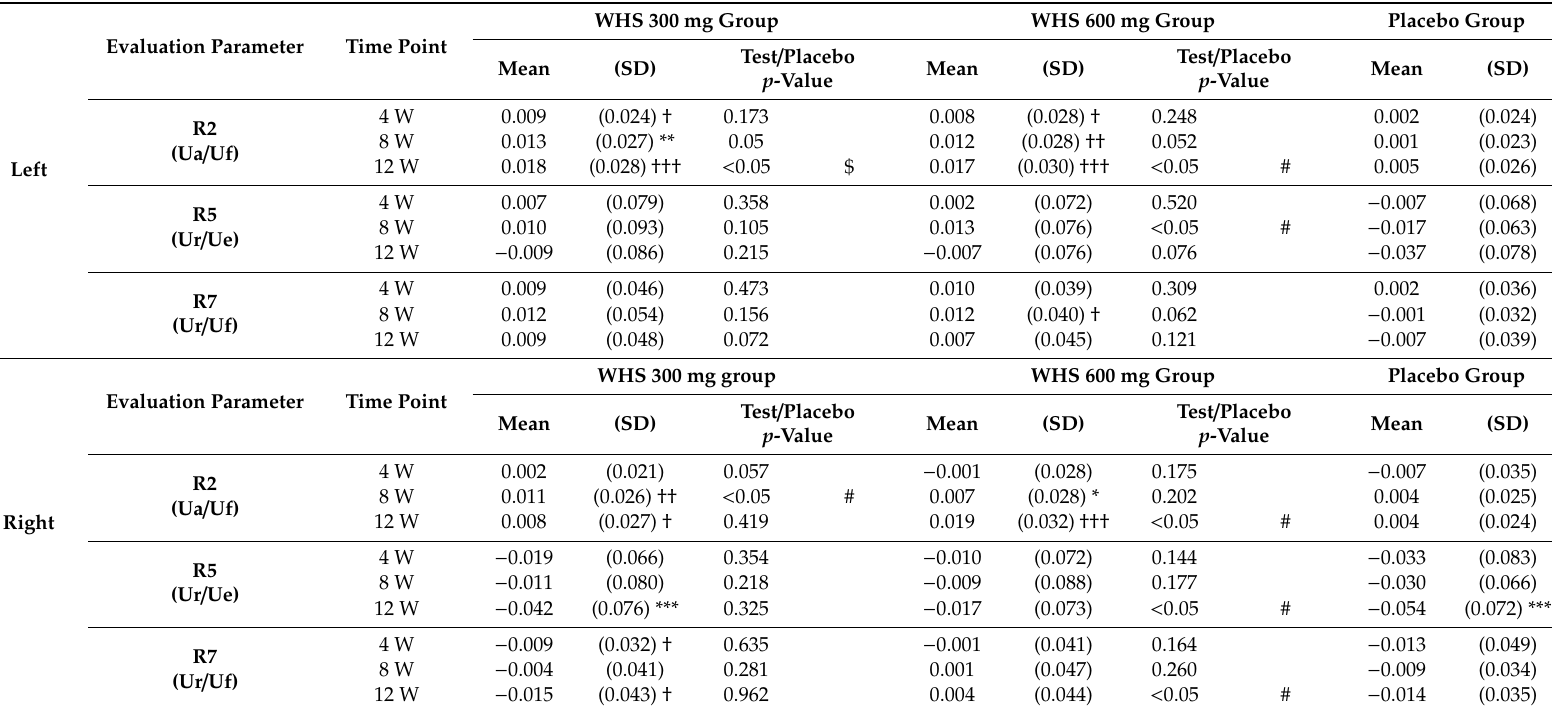
Table 2. Changes of skin elasticity measured by Cutometer